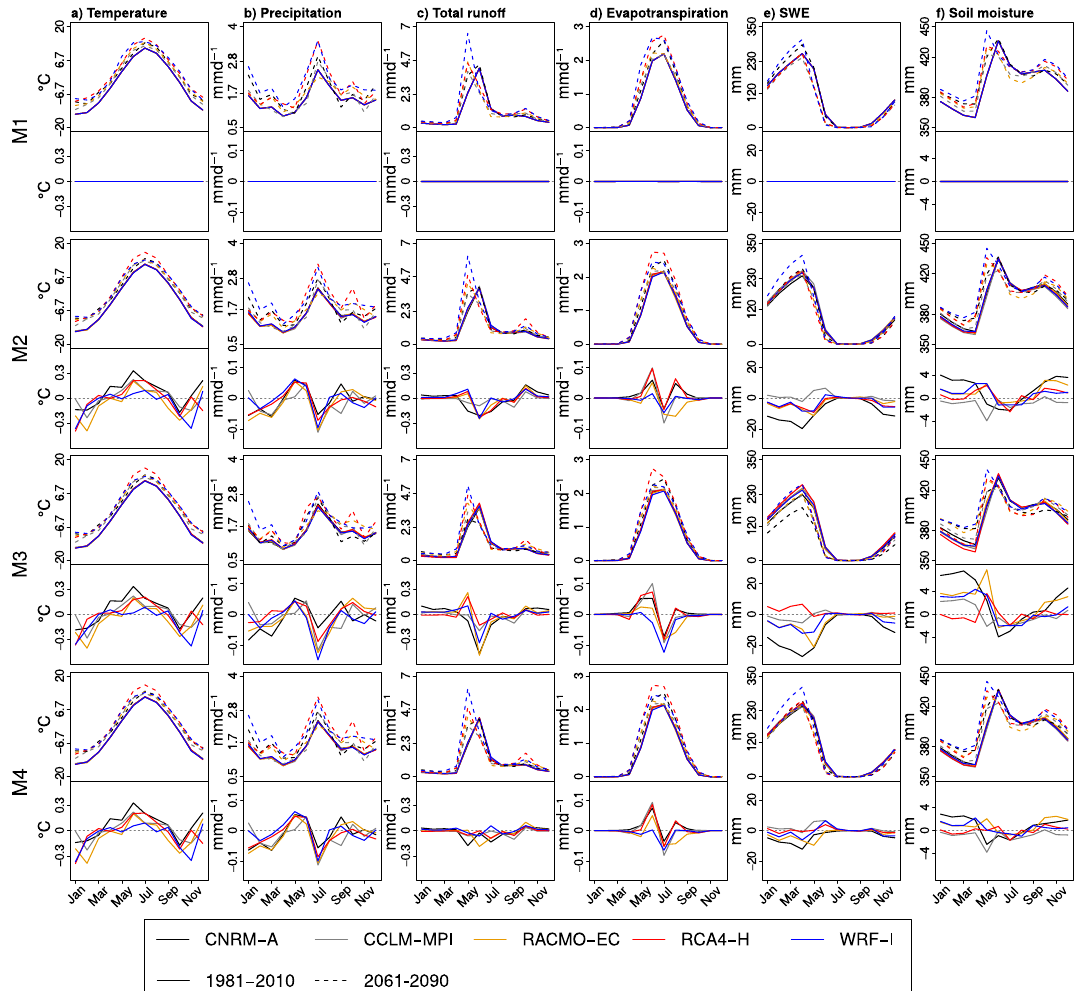
Figure 3. A real-world example showing the annual cycle of ( a ) daily mean temperature, ( b ) precipitation, ( c ) total runoff, ( d ) evapotranspiration, ( e ) snow water equivalent and ( f ) soil moisture in the Tornio river catchment in years (solid lines) 1981–2010 and (dashed lines) 2061–2090 separately for each of the GCM-RCMs when adjusted against WFDEI using the four (M1–M4) bias correction and delta change methods. To readily illustrate differences in comparison to WFDEI, the remaining biases in 1981–2010 are shown below the annual cycle panels separately for each method and